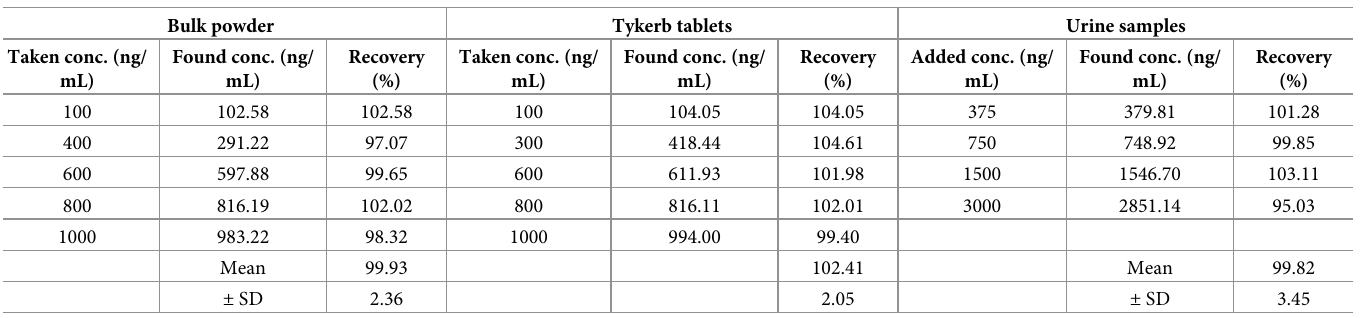
Table 2. Determination of LAP in bulk powder, Tykerb 1 tablets and urine by the proposed method. Bulk powder Tykerb tablets Urine samples Taken conc. (ng/ Found conc. (ng/ mL) mL)